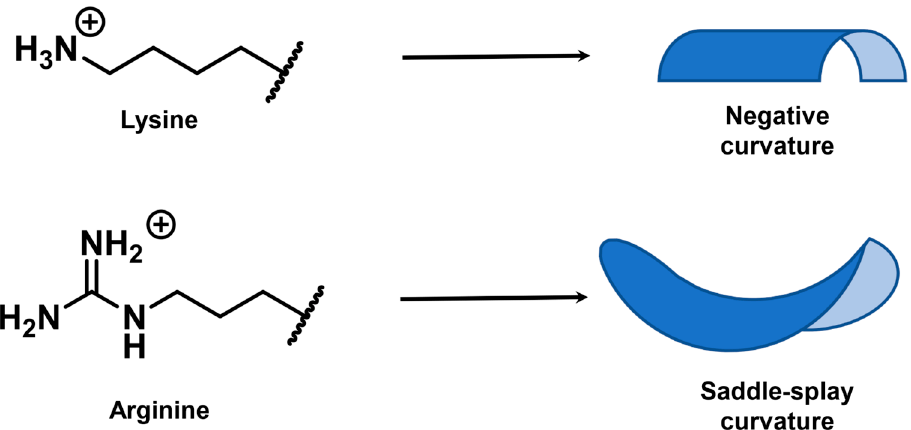
Figure 4. The different membrane deformations which are proposed to be caused by lysine and arginine. While lysine causes negative curvature, arginine causes a saddle splay deformation. The inner leaflet is shown in light blue while the outer leaflet is shown in dark blue.